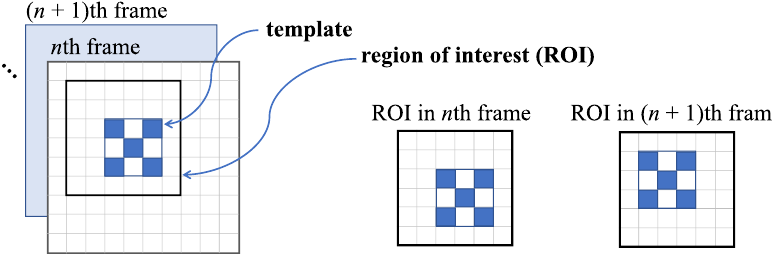
Figure 1. Scheme of a template tracked within the selected ROI in subsequent video